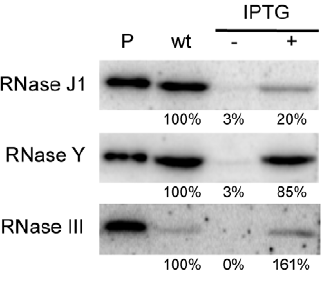
Figure 1. Western blot analysis of RNase depletion strains. Lane (P) shows signal from 50 ng purified RNase J1, RNase Y and RNase III proteins. Lanes labeled wt and 2 / + IPTG show signals from 10 m g wild type and mutant cell extracts grown in the absence and presence of IPTG.